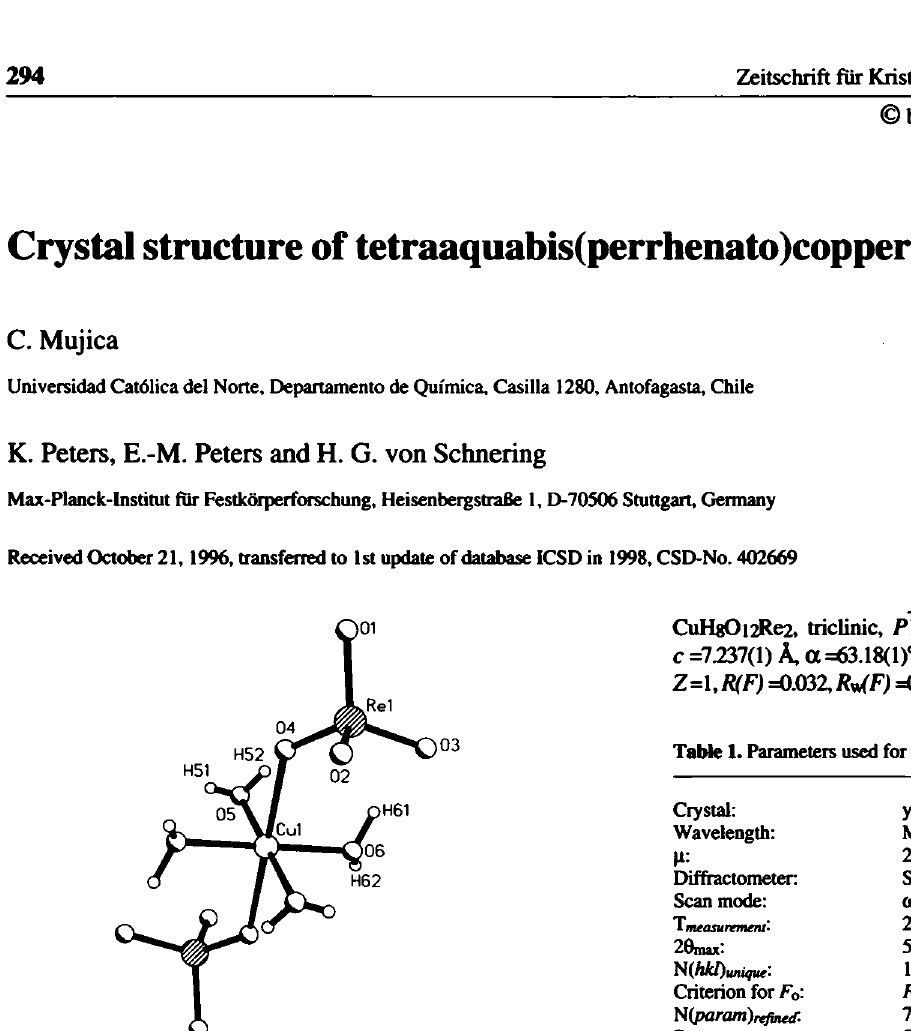
Table 2. Final atomic coordinates and displacement parameters (in Â 2